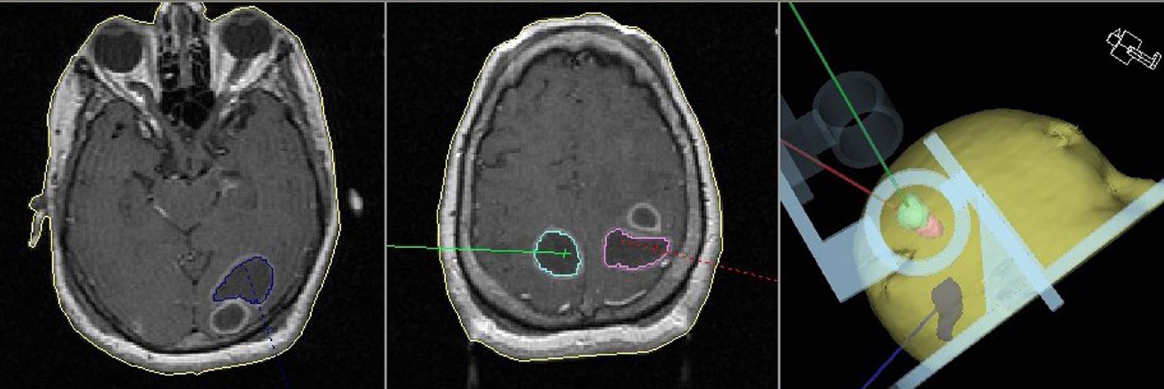
Fig. 3 An illustrative case. Preoperative stereotactic planning MRI and 3D simulation with 3 trajectories. Histological diagnosis was multiple brain